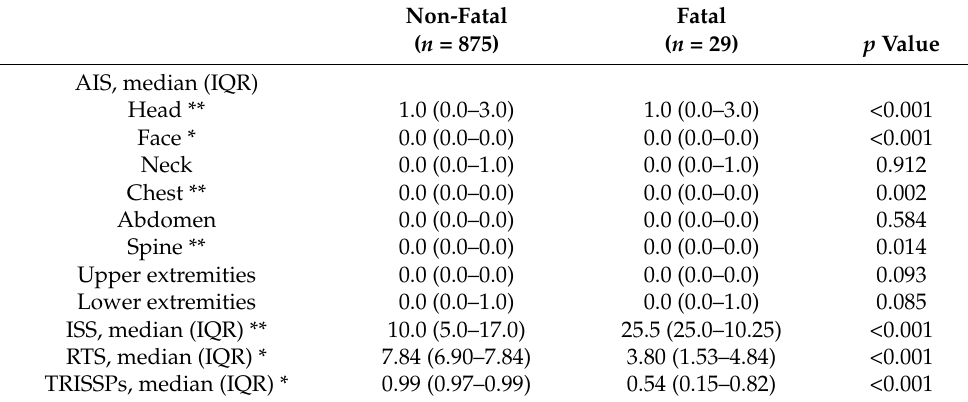
Table 2. Comparison of the Abbreviated Injury Scale (AIS) score by body region, Injury Severity Score (ISS), Revised Trauma Score (RTS), and Trauma and Injury Severity Score Probability of Survival (TRISSPs) in patients aged < 15 years between the fatal and non-fatal groups (2004–2019). * The median value in the non-fatal group was significantly higher than that in the fatal group. ** The median value in the non-fatal group was significantly lower than that in the fatal group.